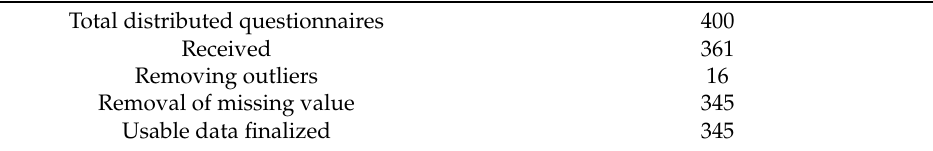
Table 1. Survey response